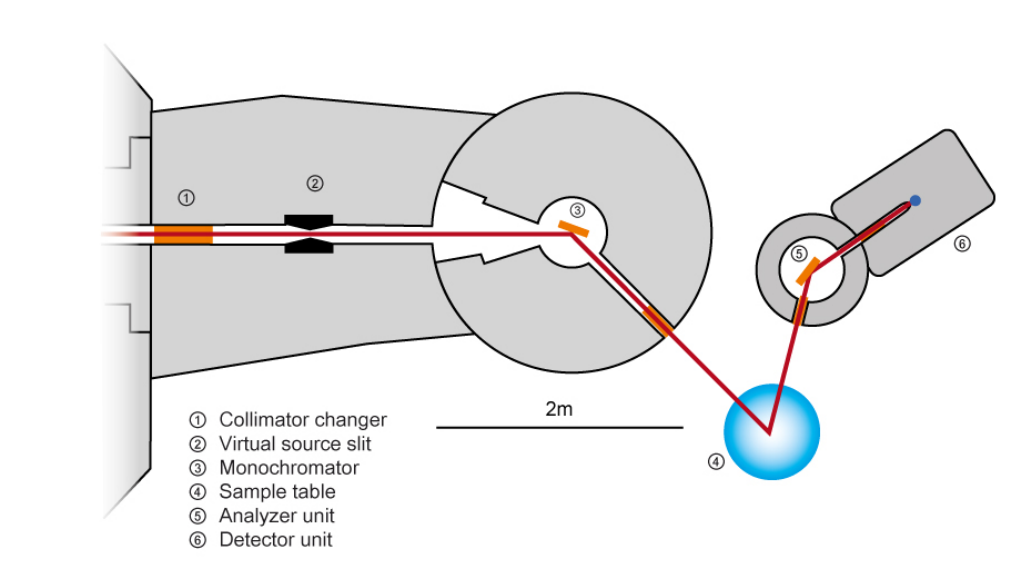
Figure 2: Schematic drawing of